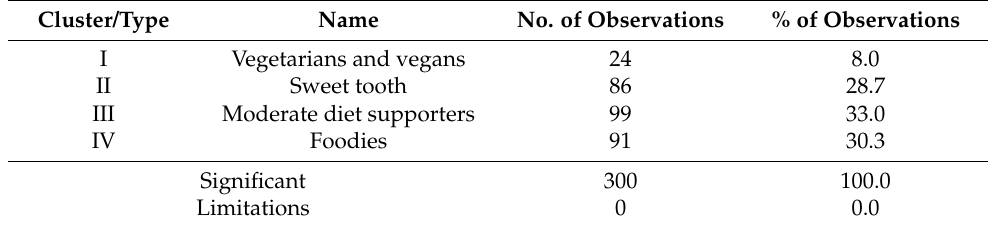
Table 7. Types of Slovak consumers by food and non-alcoholic beverages